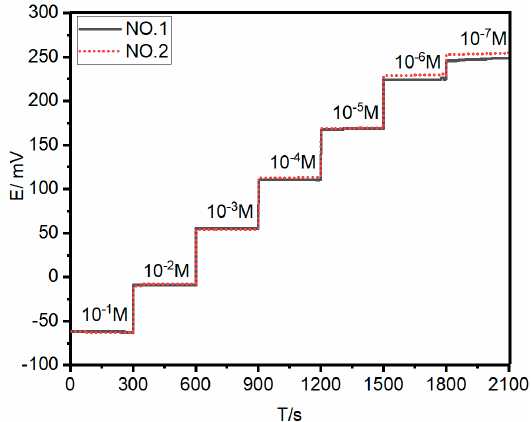
Figure 8. The calibration process of two electrodes (Nos. 1 and 2) in KBr prepared in freshwater.